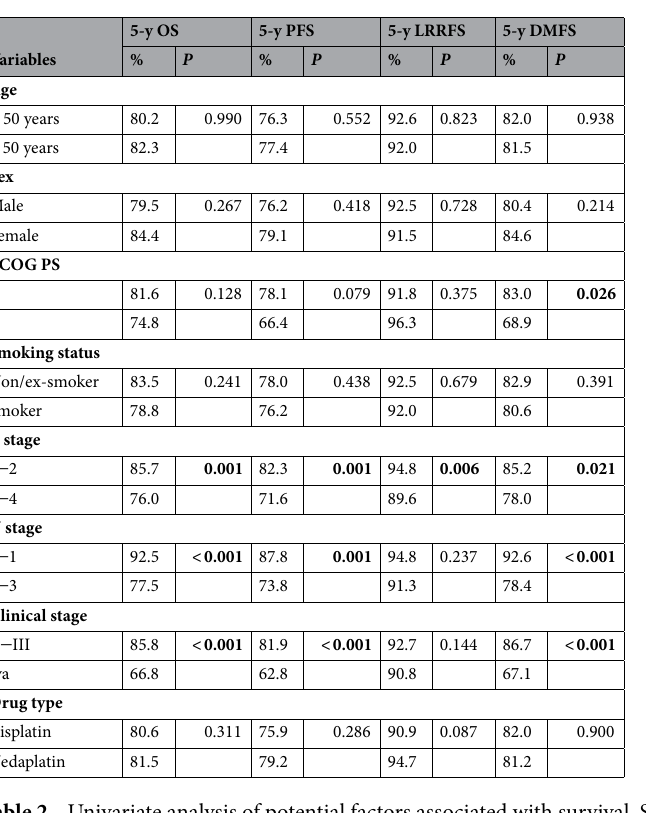
metastasis-free survival, ECOG PS Eastern Cooperative Oncology Group Performance Status.